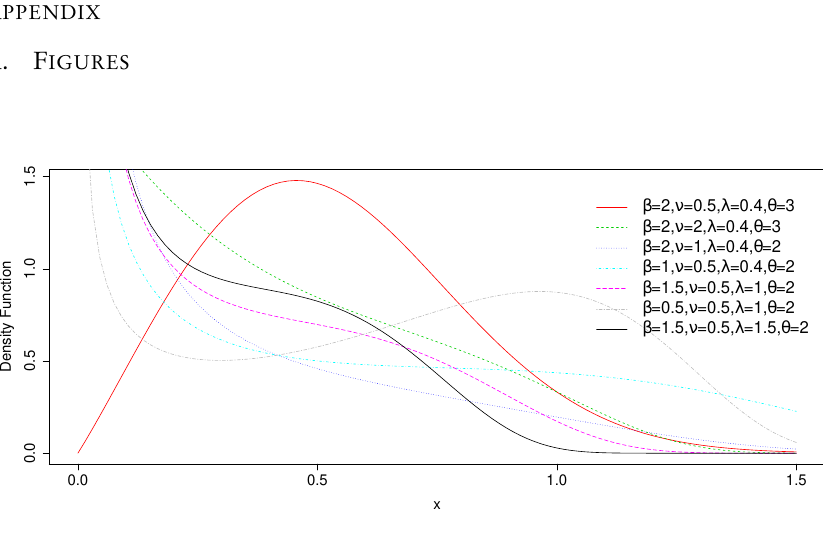
Figure 1 – The plots of density function of the EMW distribution for different choices of the